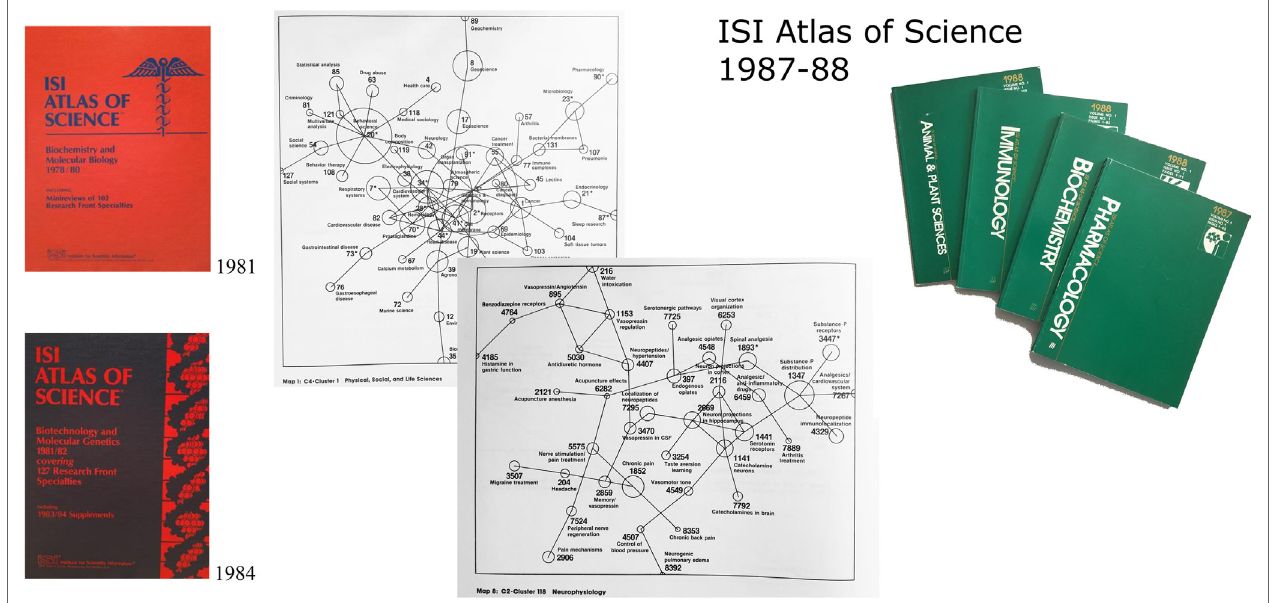
FiGURE 2 | ISI Atlas of Science (scanned covers and diagrams reproduced with permission of Clarivate